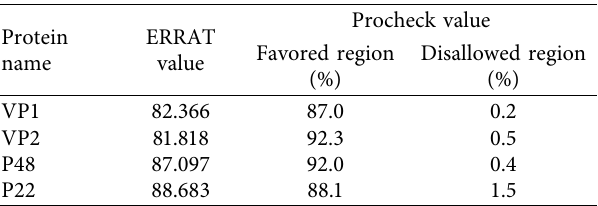
Table 1: Refined protein model with their ERRAT value and PROCHECK